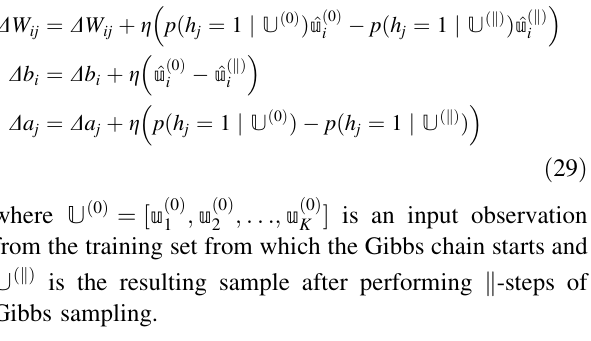
layer of the DBM and it contains T l number of binary- valued hidden units. W ¼ ½ w ij (cid:3) represents the weights between nodes in the visible layer and the nodes in the first hidden layer h ð 1 Þ . b i is the bias term associated with i -th visible layer node u i . W ð ‘ Þ ¼ ½ w ð ‘ Þ (cid:3) where 1 (cid:8) ‘ (cid:8) L is the jk weight between the j -th node in the hidden layer h ð ‘ Þ and the k -th node in the hidden layer h ð ‘ þ 1 Þ . a ð ‘ Þ j